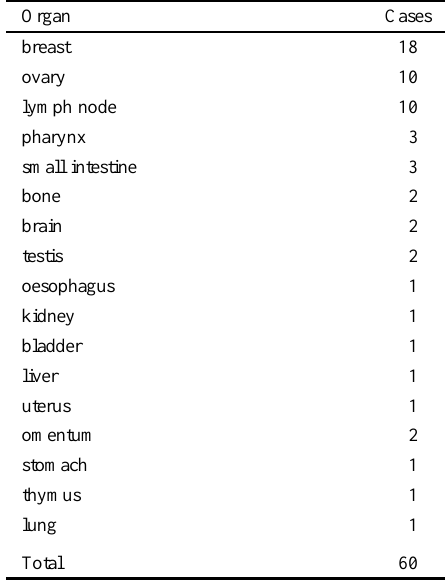
A summary of organs involved in frozen section